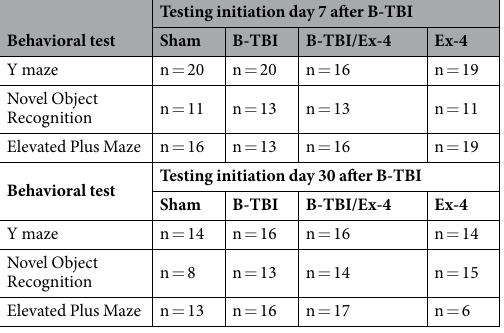
Table 2. Post-injury animal treatment groups. The animal numbers were as follows when Ex-4 was administered after the blast